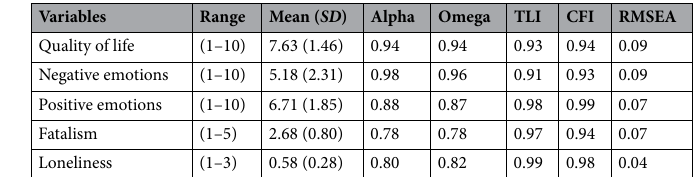
Table 1 represents the descriptive results for the indicators of this study as well validity and reliability indica- tors. As observed, the mean scores for positive emotions ( M = 6.71) and quality of life ( M = 7.63) present a mean above the median of the scale range assessed as opposed to negative emotions ( M = 5.18), fatalism ( M = 2.68) and loneliness ( M = 0.58), whose values have a lower mean compared to the range median of these indicators. Regarding CFA analysis, good fit indicators presented are adequate according literature. As well, reliability indi- cators presented in Table 1 are higher than 0.70. Prior to the linear regression and moderation analyses, a correlation analysis was performed between the variables in the hypothesis of this study. The results of Pearson correlations are presented in Table 2. As observed, all the relationships between variables were significant. ( p < 0.01). However, based on the standard interpretation of effect size 47 , there is a strong association between quality of life and positive emotions ( r = 0.54), while the associations between loneliness and quality of life ( r = −0.49), loneliness and positive emotions ( r = −0.38), loneli- ness and negative emotions ( r = 0.39), fatalism and negative emotions ( r = 0.30), and quality of life and positive emotions ( r = −0.39) are moderate. The rest of associations show a weak level of association.